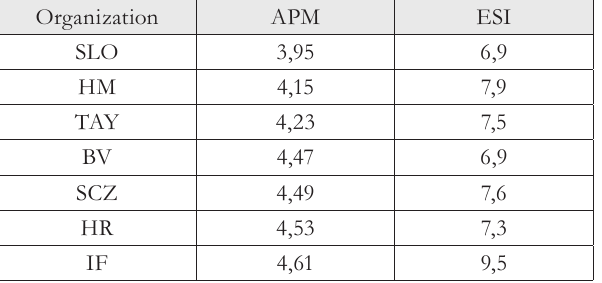
Tab. 4 – An example of assessment table. Source: own.